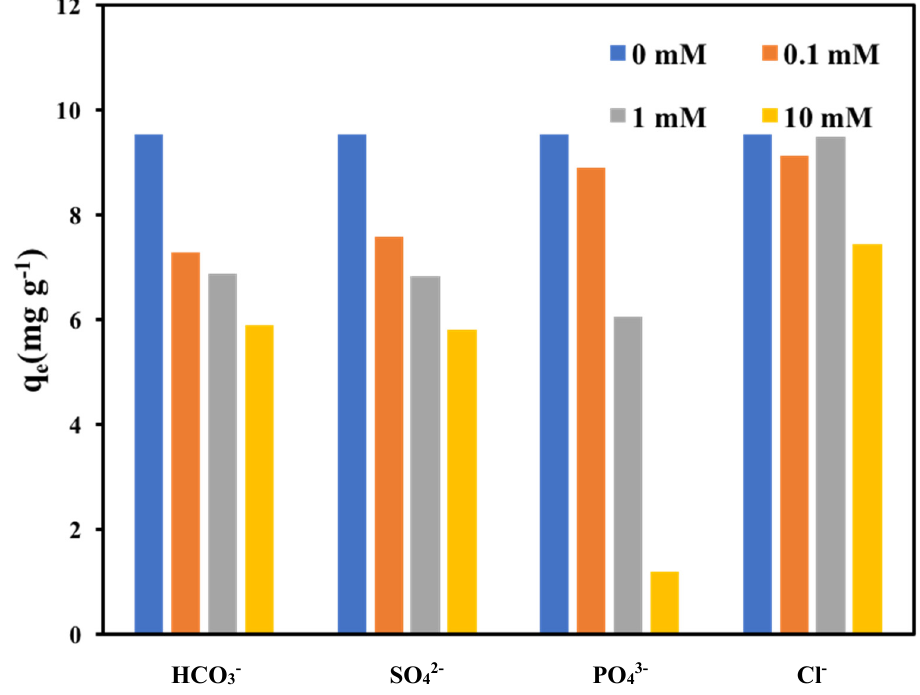
Figure 9. Effect of co-existing ions on As removal by the D-Cr gel.